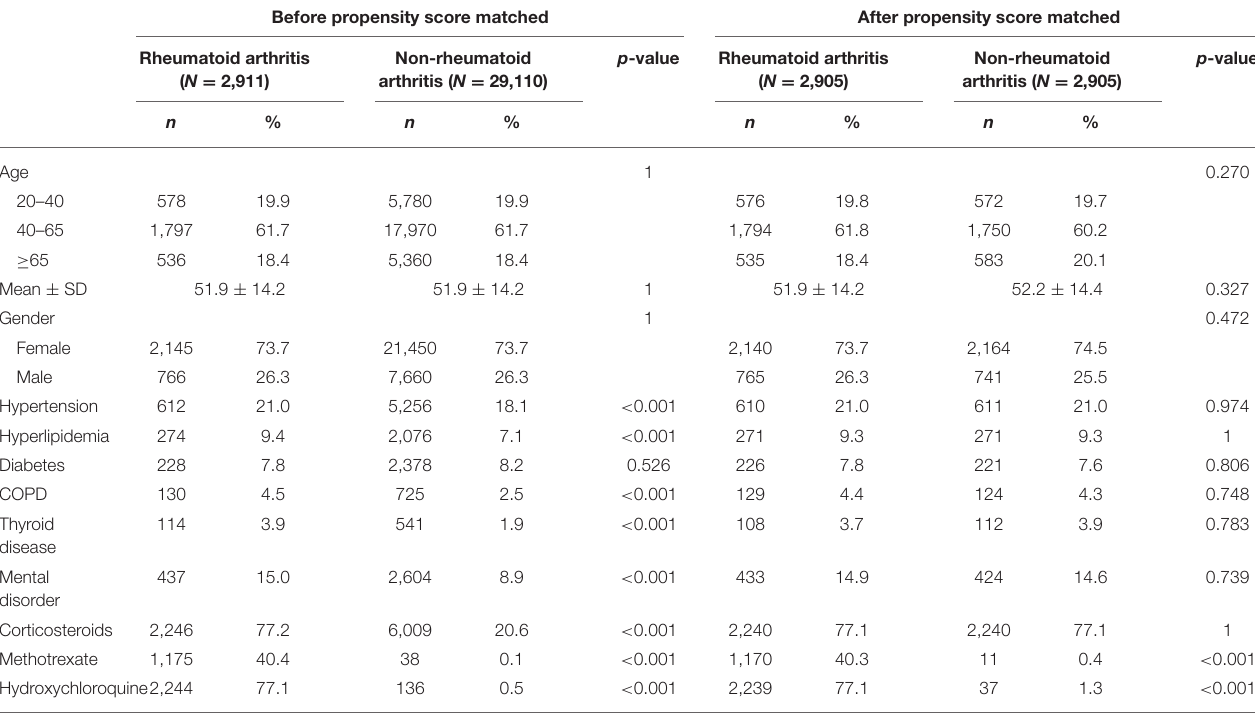
TABLE 1 | Demographic characteristics of rheumatoid arthritis and non-rheumatoid arthritis. Before propensity score matched After propensity score matched p -value Rheumatoid arthritis p -value Rheumatoid arthritis Non-rheumatoid Non-rheumatoid ( N = 2,911) arthritis ( N = 29,110) ( N = 2,905) arthritis ( N = 2,905)